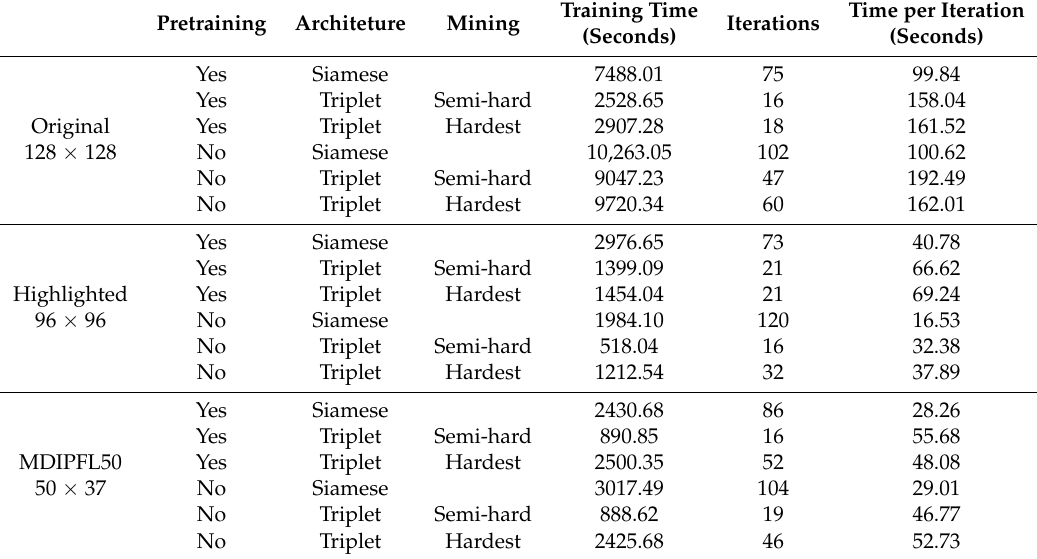
Table 2. The measured runtimes of the experiments for training on the NIST SD19. Each iteration took 500 steps. Times of pretraining not